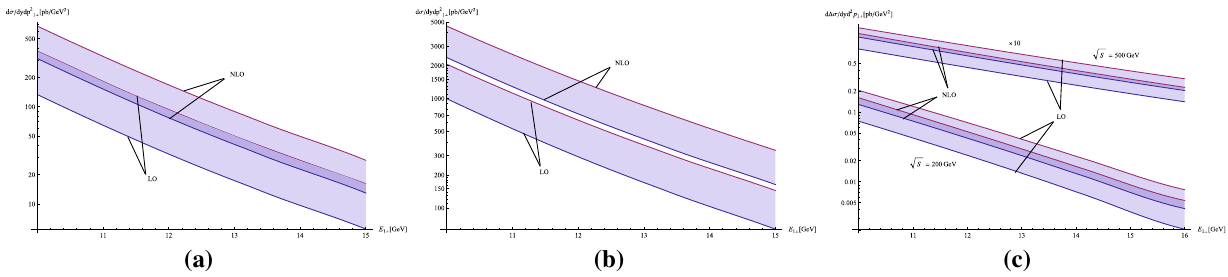
Fig. 5 Transversity PDFs and unpolarized PDFs for u( ¯ u ) and d( ¯ d ) quarks at two different scales in our model. In each diagram, the dashed and real lines stand for PDFs at μ = 5GeV and